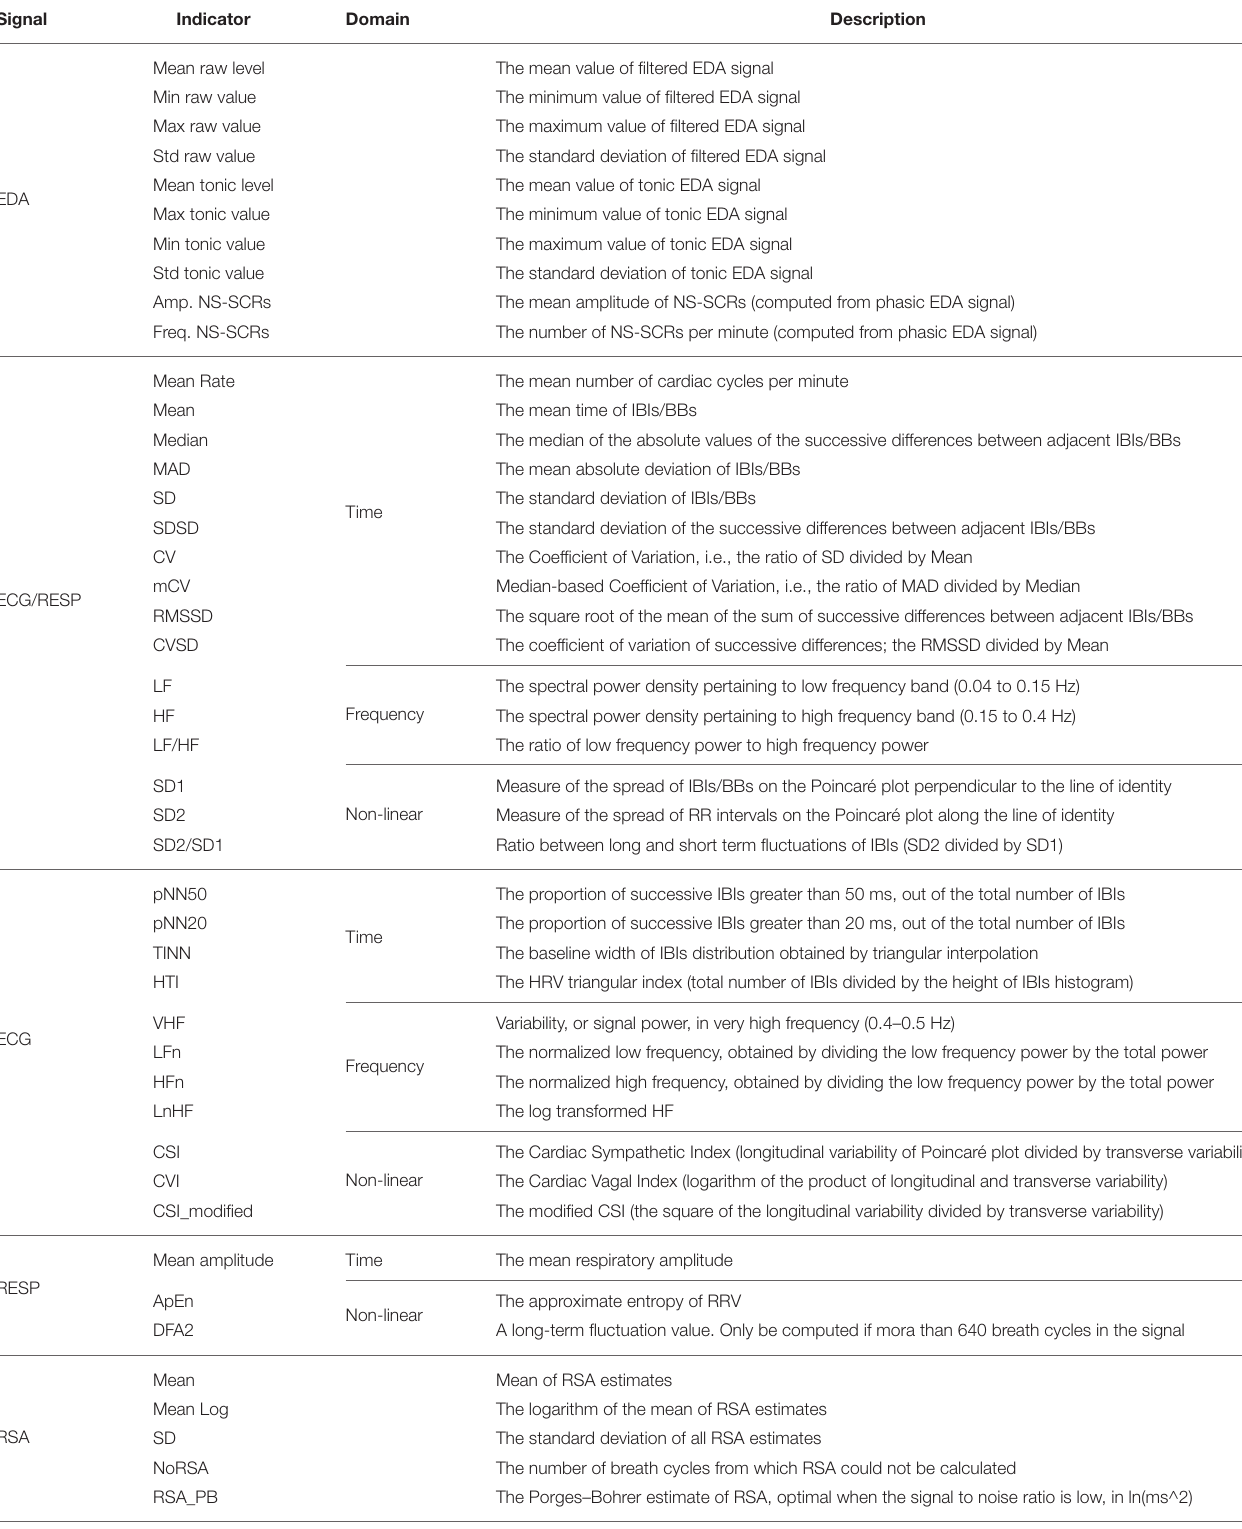
TABLE 2 | Summary of physiological indicators computed from raw physiological signals.